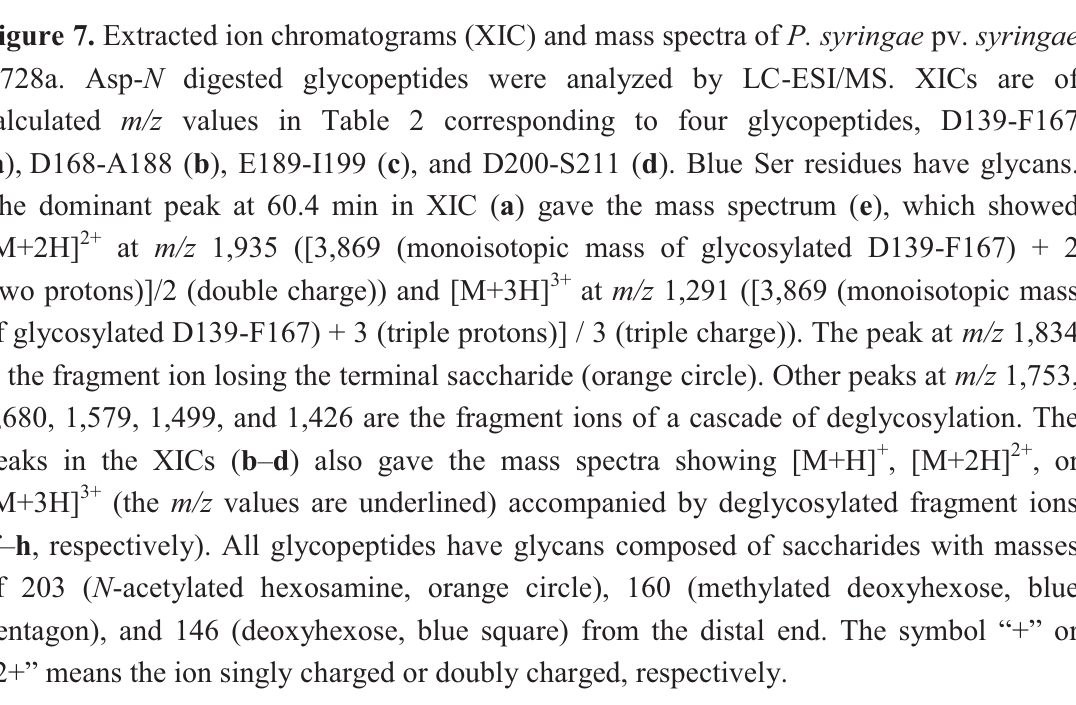
Figure 7. Extracted ion chromatograms (XIC) and mass spectra of P. syringae pv. syringae B728a. Asp- N digested glycopeptides were analyzed by LC-ESI/MS. XICs are of calculated m/z values in Table 2 corresponding to four glycopeptides, D139-F167 ( a ), D168-A188 ( b ), E189-I199 ( c ), and D200-S211 ( d ). Blue Ser residues have